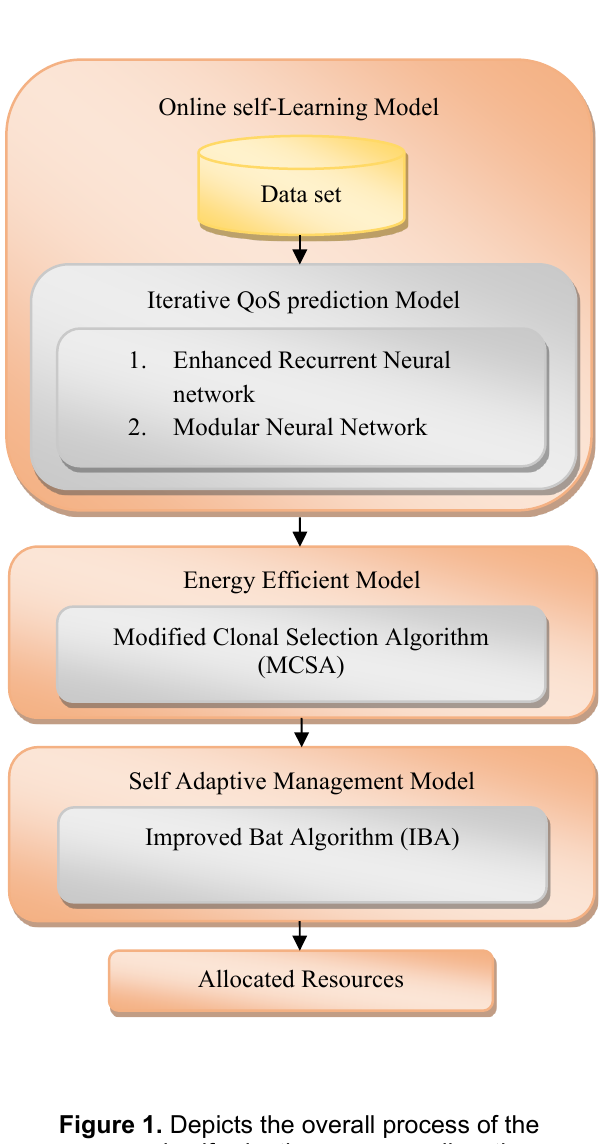
Figure 1. Depicts the overall process of the proposed self-adaptive resource allocation